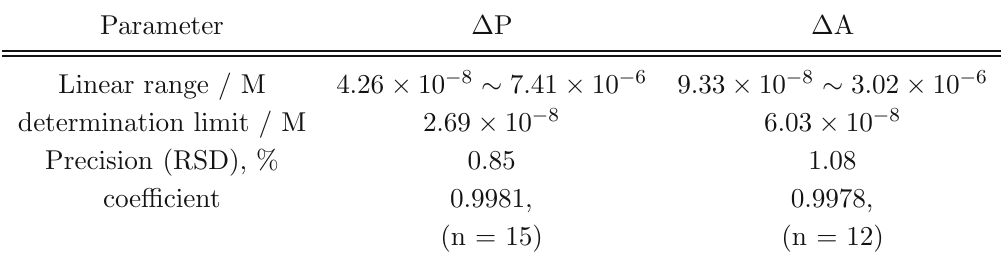
Table 1 Determination of sulfanilamide concentration with the proposed